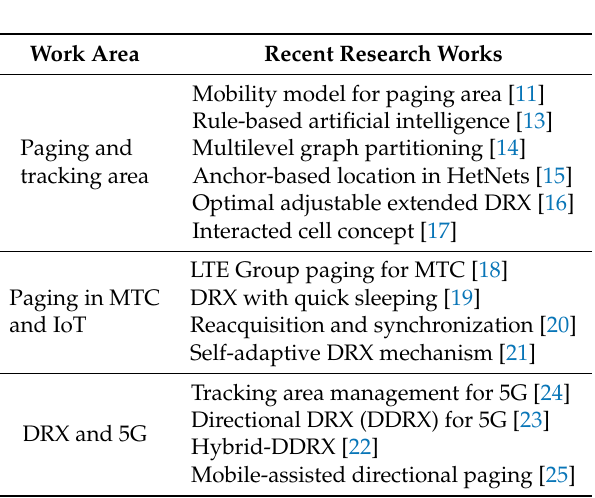
Table 2. Recent related